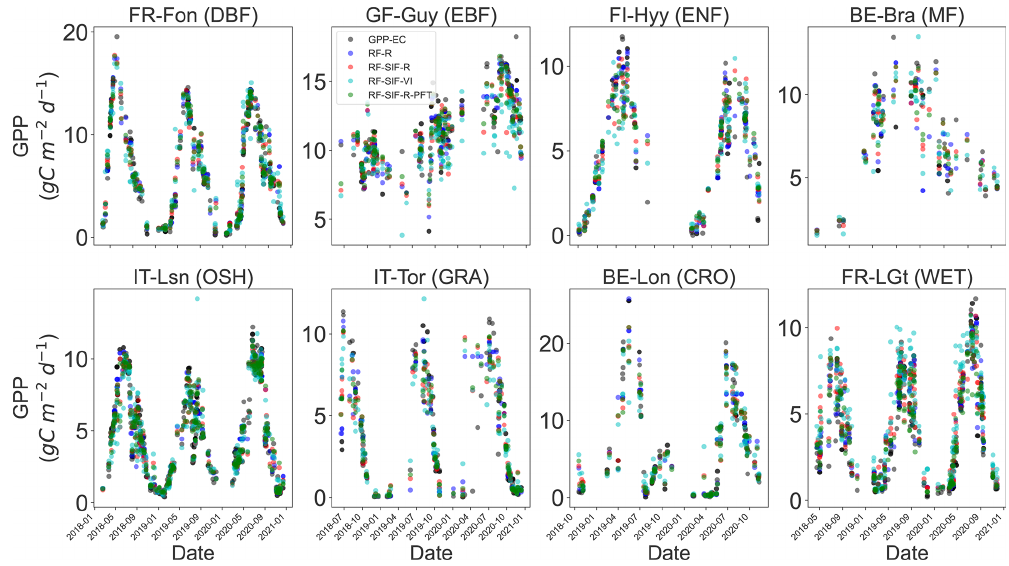
Figure 8. Comparison between observed GPP and RF-regression-model-estimated GPP at selected ICOS flux sites representing different PFTs: DBF, EBF, ENF, MF, CRO, GRA, OSH, and WET. The color code represents the different RF GPP predictions and the observed GPP: red stands for RF-SIF- R , green for RF-SIF- R -PFT, blue for RF- R , cyan for RF-SIF-VI, and black for observed